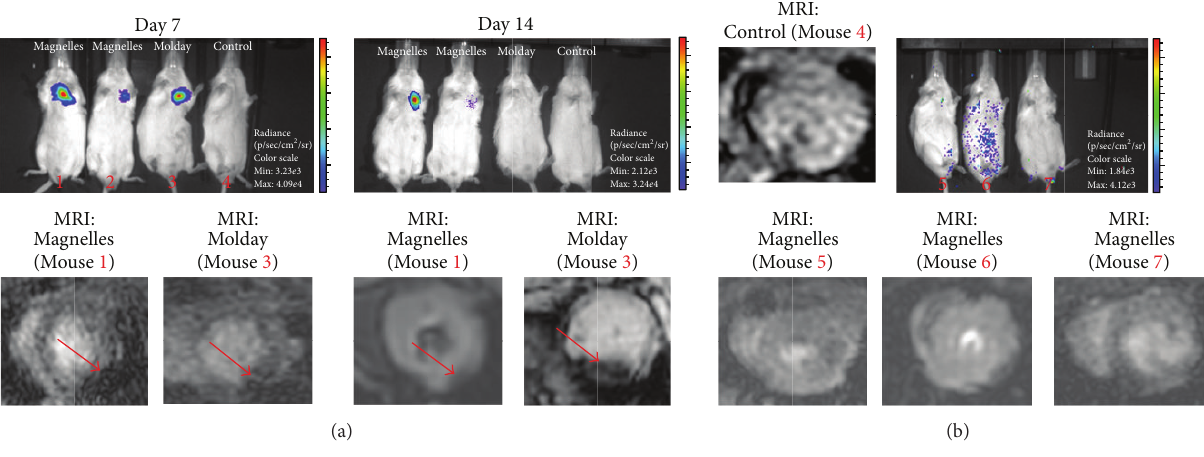
Figure 4: (a) Representative BLI images of the mice injected with Magnelle and Molday ION labeled reporter gene-transduced iCMs or PBS alone as control, after days 7 and 14 of cell injections (top) and their corresponding in vivo MRI images of the murine hearts (bottom); red arrows show the signal from the injected labeled cells. (b) Representative BLI images of the selected mice with dead cardiomyocytes (after day 14 of Magnelle labeled cells) and the corresponding in vivo MRI